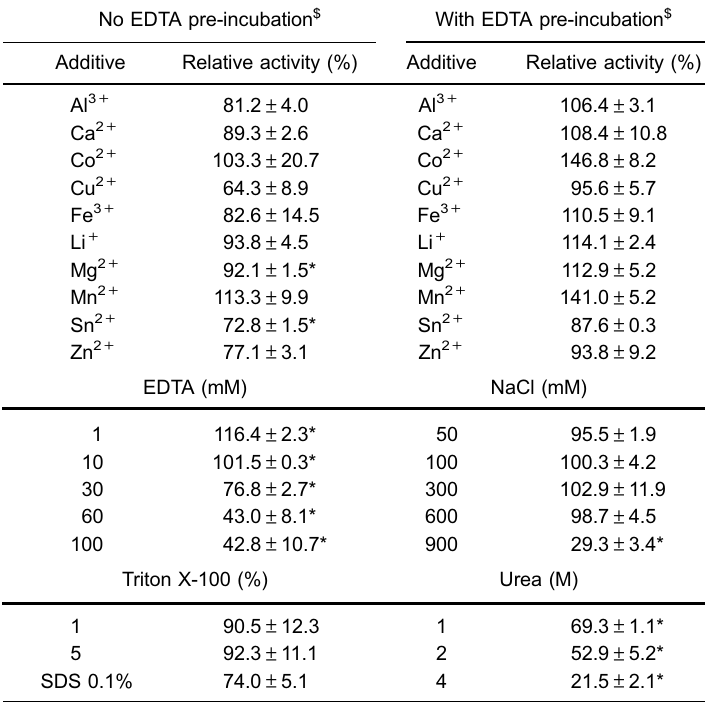
Table 1. Effect of additives on activity of MetaChi18A.